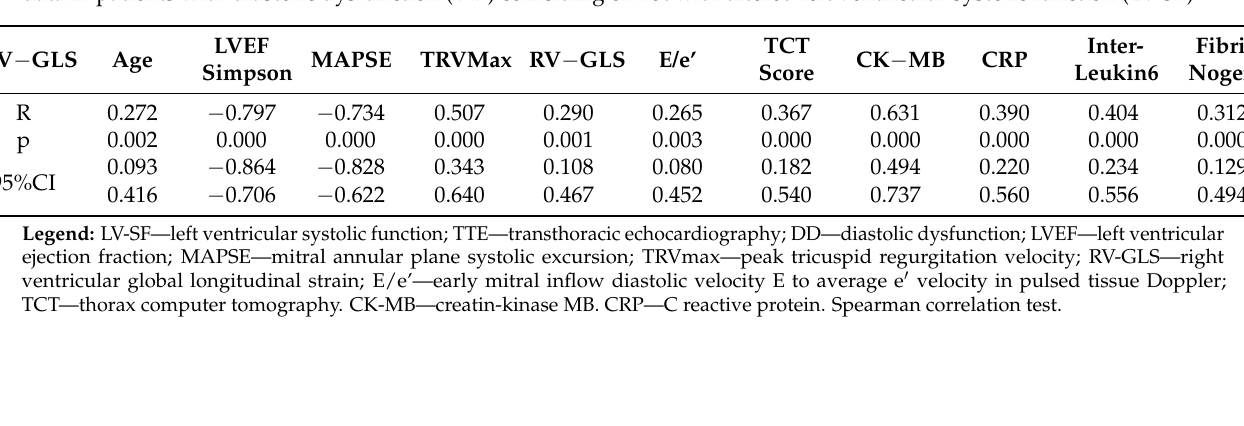
Patients with DD with and without Altered LV-SF n = 32 (25.6%)